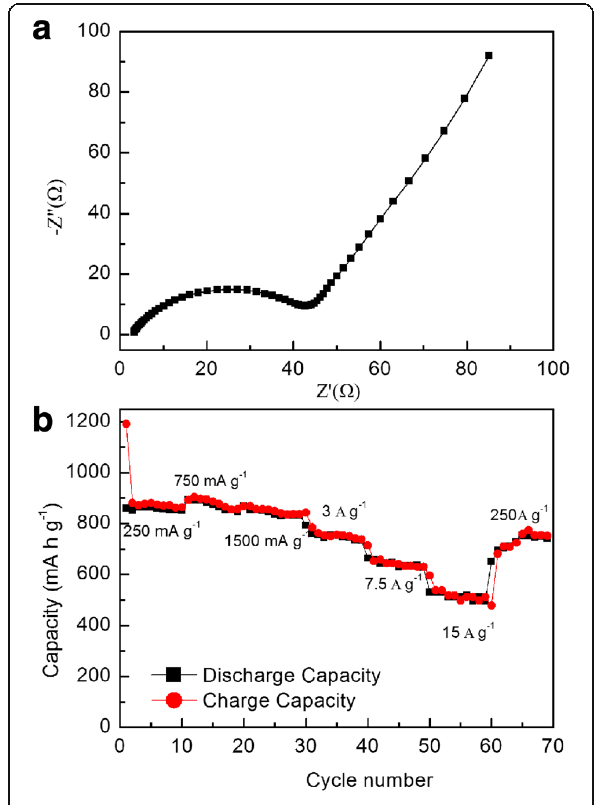
Fig. 7 a Electrochemical impedance spectra of the nanocrystalline Fe 2 O 3 film. b Rate capabilities of the nanocrystalline Fe 2 O 3 film at different specific